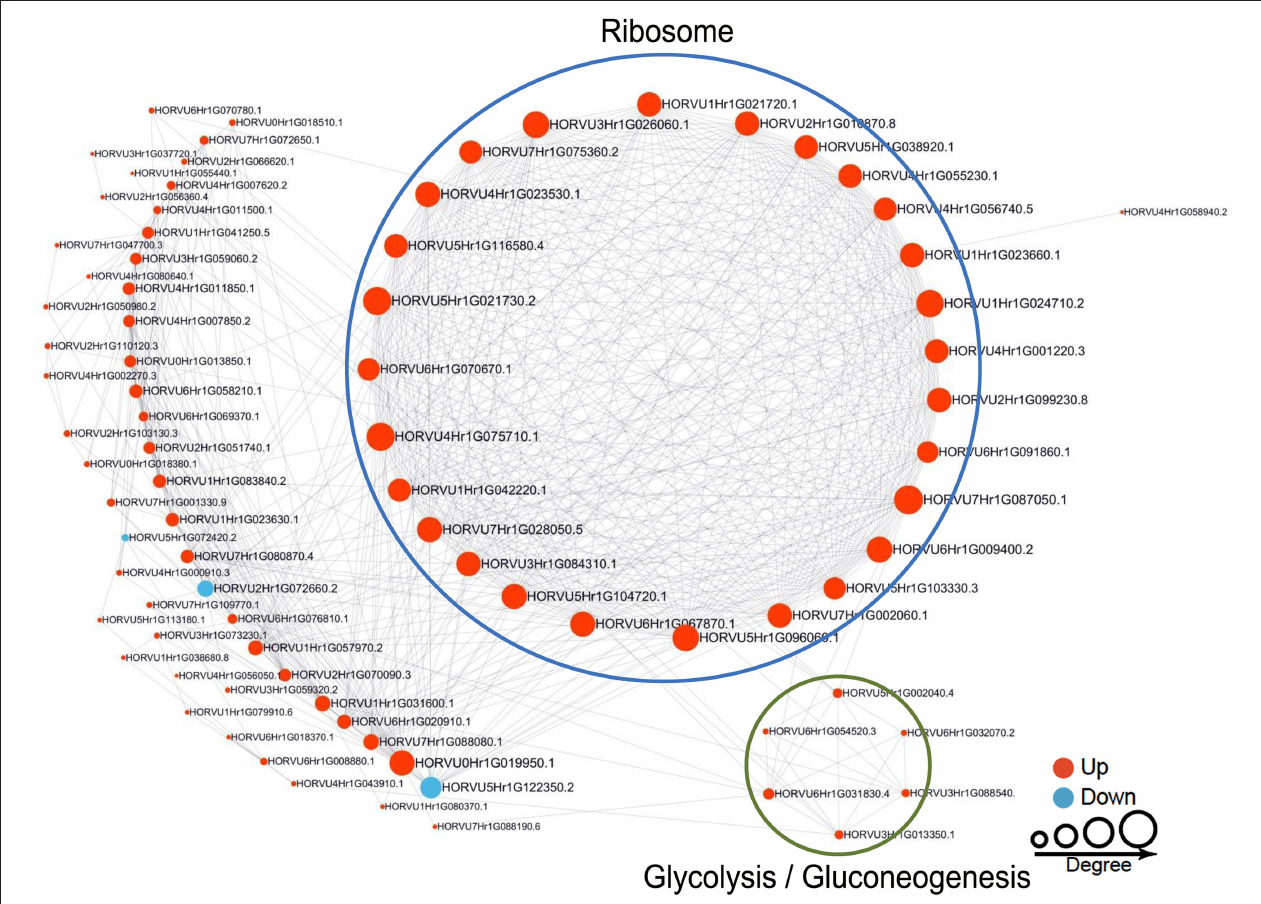
FIGURE 9 | Protein–protein interaction (PPI) network of succinylated proteins in response to Pi recovery. Same as Figure 8